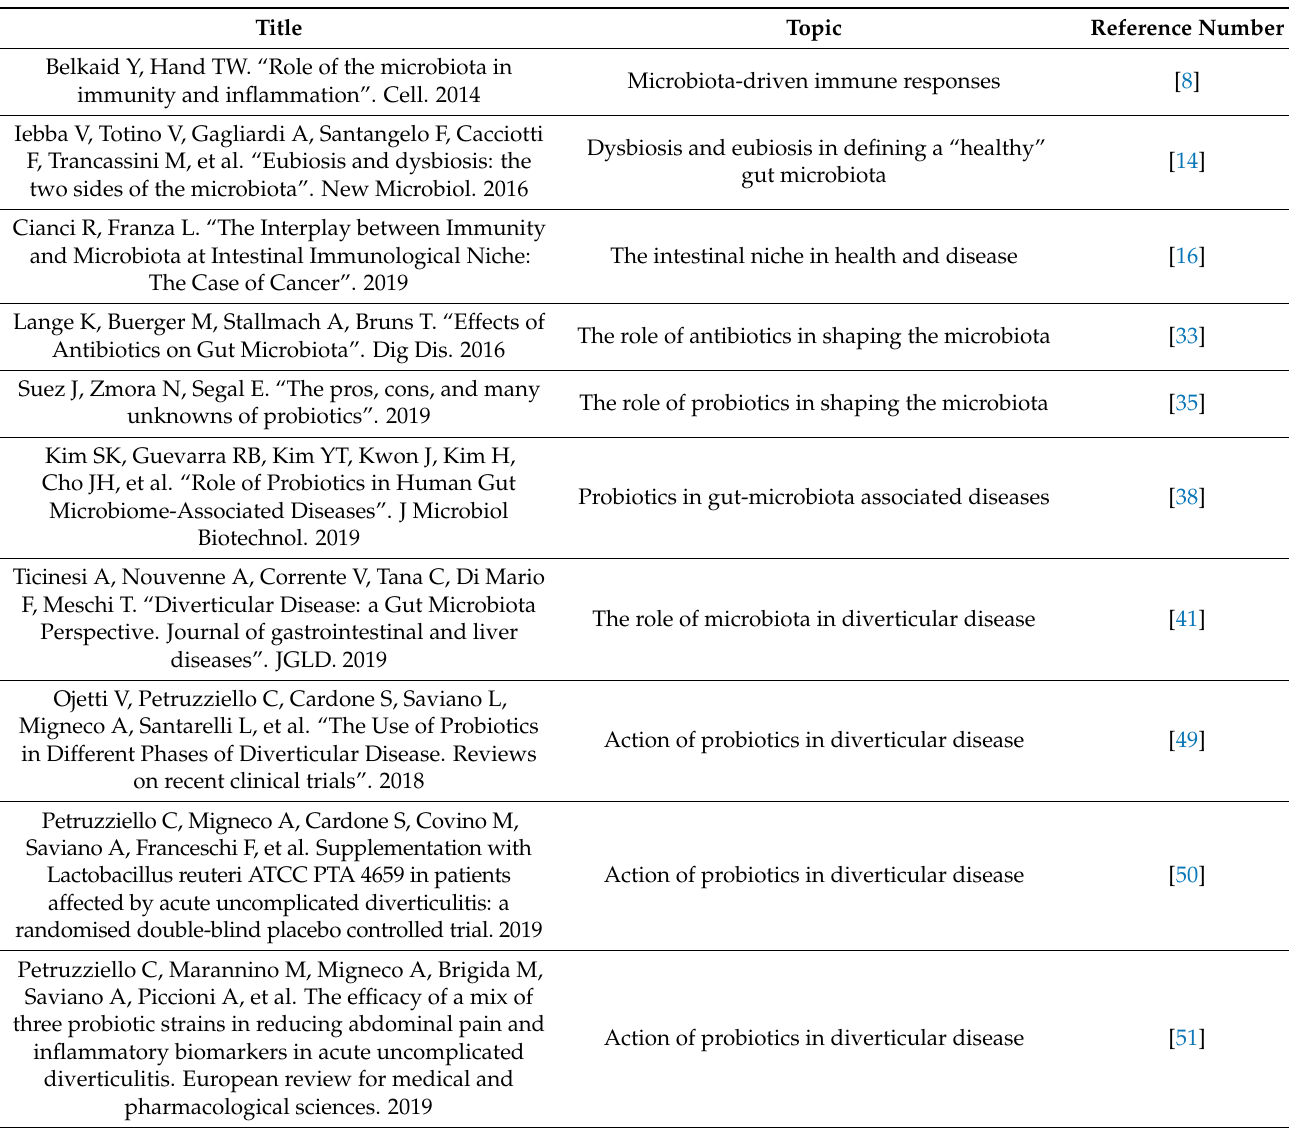
Table 1. Summary of the most relevant